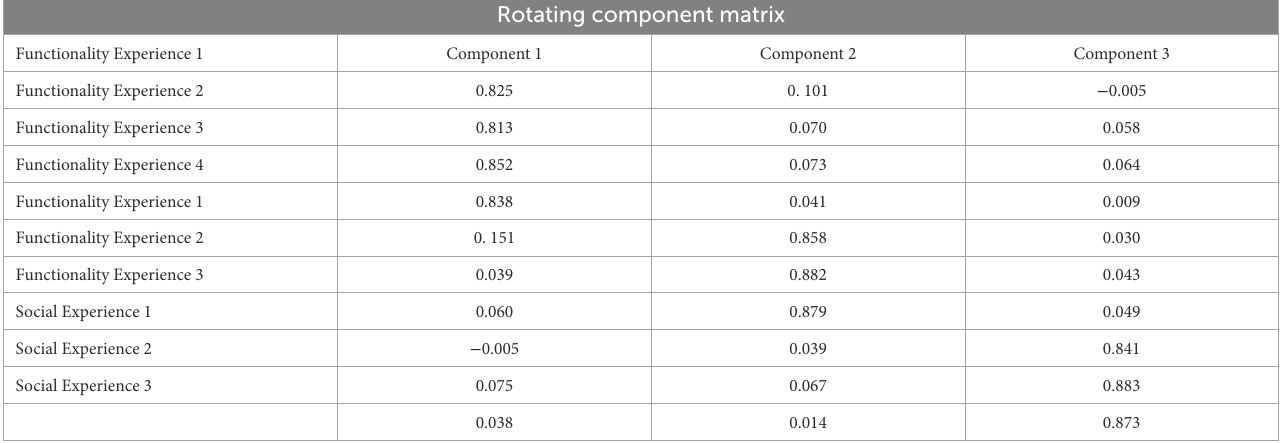
TABLE 10 Calculated results of orthogonal rotation of empirical scale